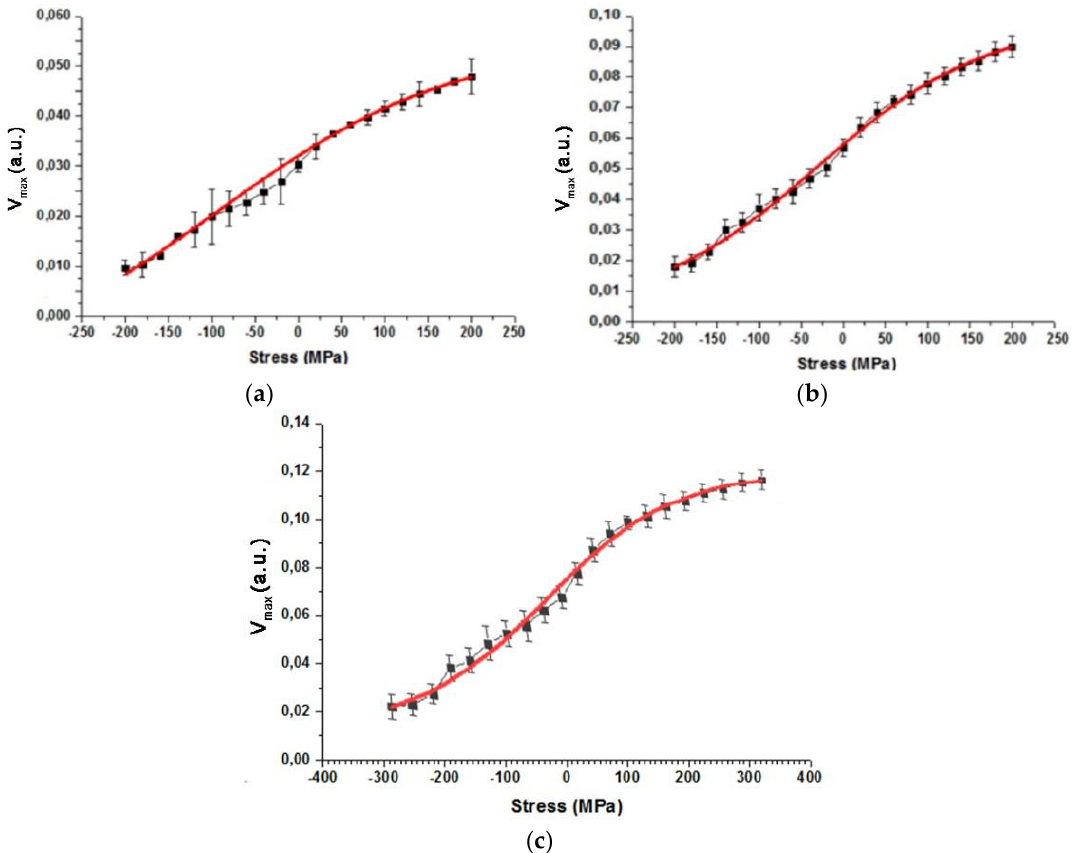
Figure 2. Magnetic Stress Calibration (MASC) curves for ( a ) NOES; ( b ) AISI 1008 and ( c ) AISI 4130 steel. The black marks with the error bars indicate the measured permeability values at each residual stress level while the red line is a fitted curve.